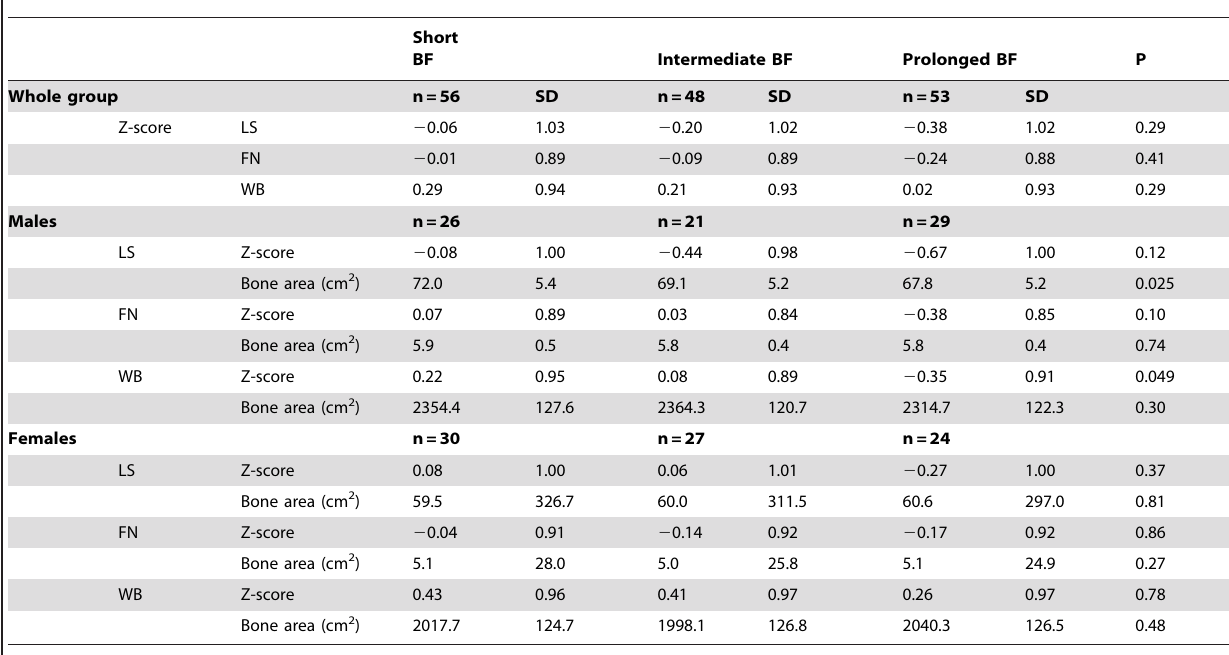
Table 2. BMD Z-scores and bone areas in the three study